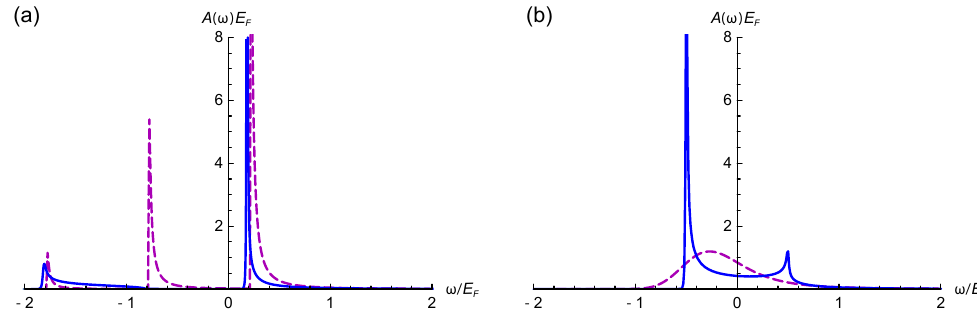
Figure 9. Spectral function of an infinitely heavy impurity in an ideal Fermi gas at T = 0.01 E F (blue, solid) [52] or an ideal Bose gas at T = 0 [113] (purple, dashed). We show the result for 1/ k F a = 1 ( a ) and 1/ k F a = 0 ( b ). On the left, the two attractive peaks in the Bose case are due to single or double occupation of the impurity-boson bound